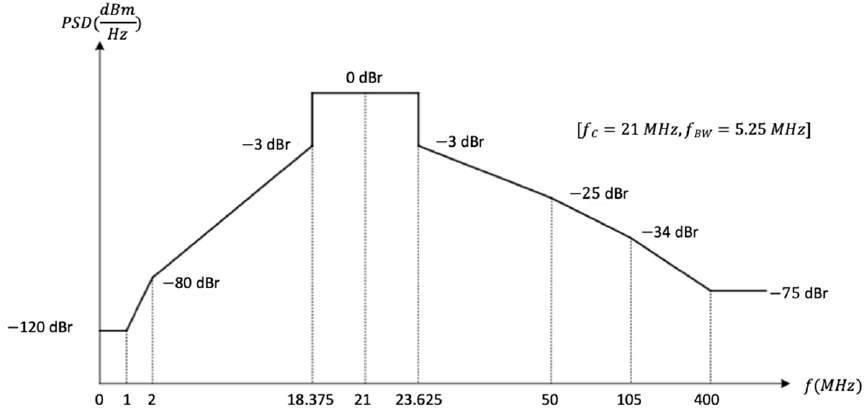
Figure 2. 802.15.6 Transmit spectral mask.